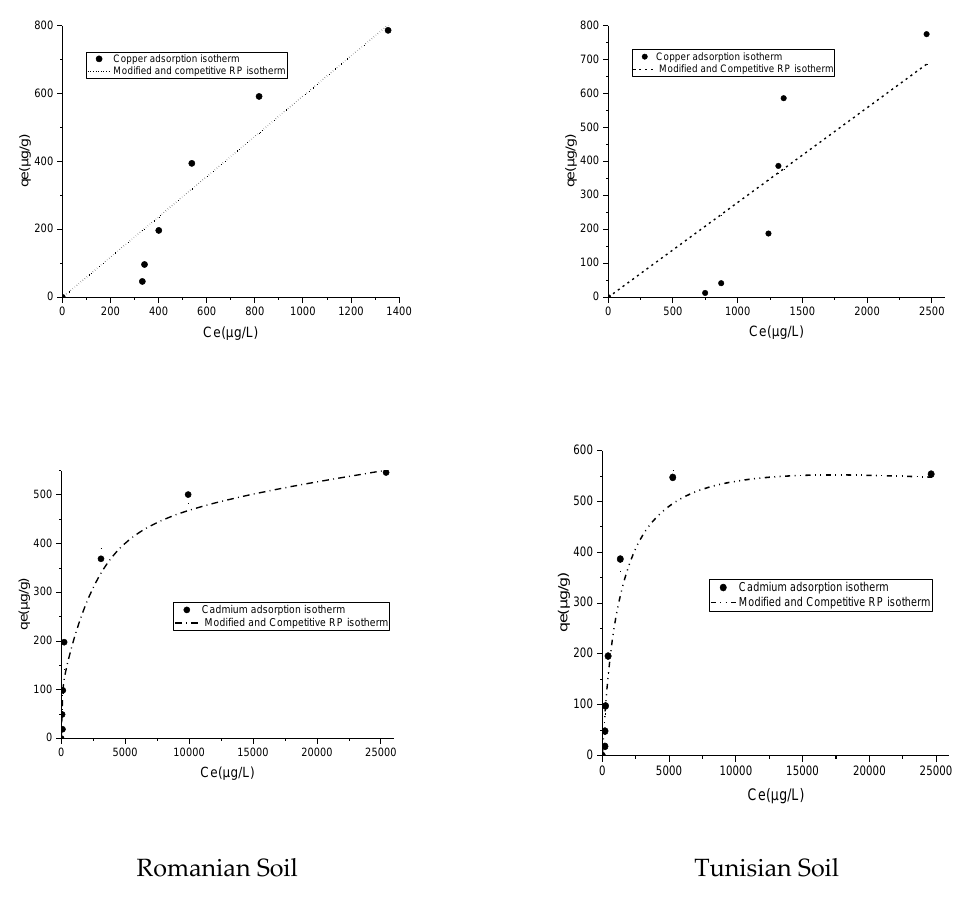
Figure 4. Cadmium and copper adsorption isotherms in Romanian and Tunisian soils (T = 22 °C, 260 rpm, m/V = 0.1 g · mL − 1 , pH = 7.0 – 7.5).